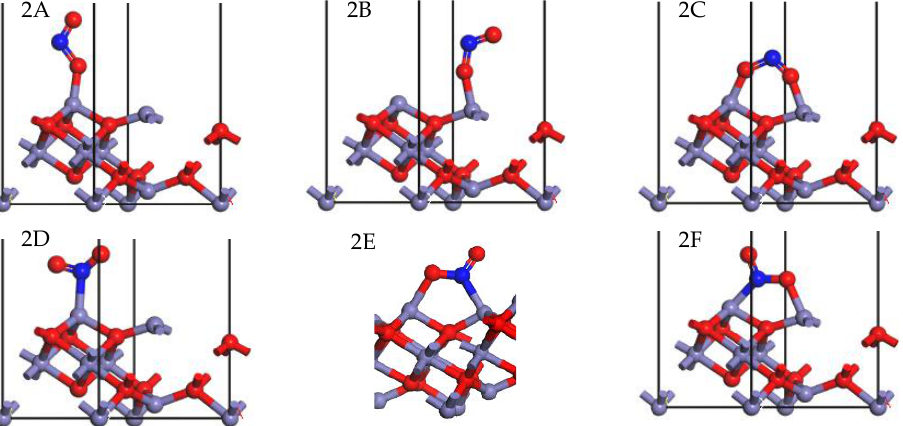
Figure 5. Stable adsorption configurations of NO 2 onto the γ -Fe 2 O 3 (111) surface (N, blue; Fe, purple; O, red).